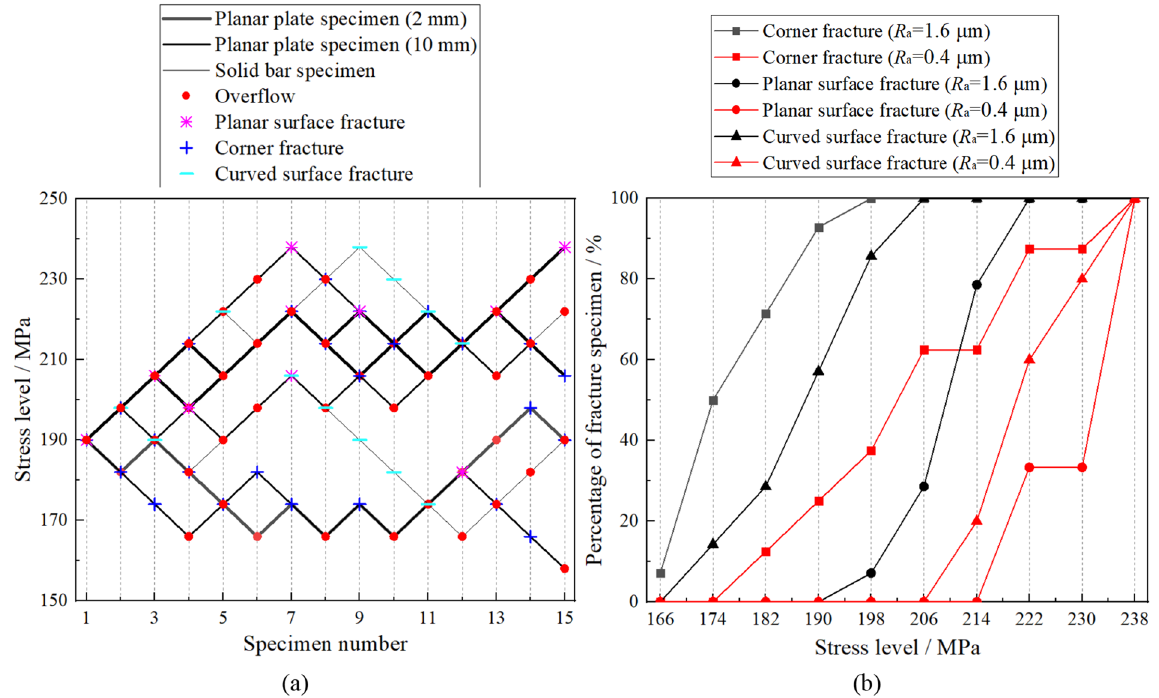
Figure 4. Up-and-down chart of the 8 groups of specimens ( a ) and distributions of the three kinds of fracture modes ( b